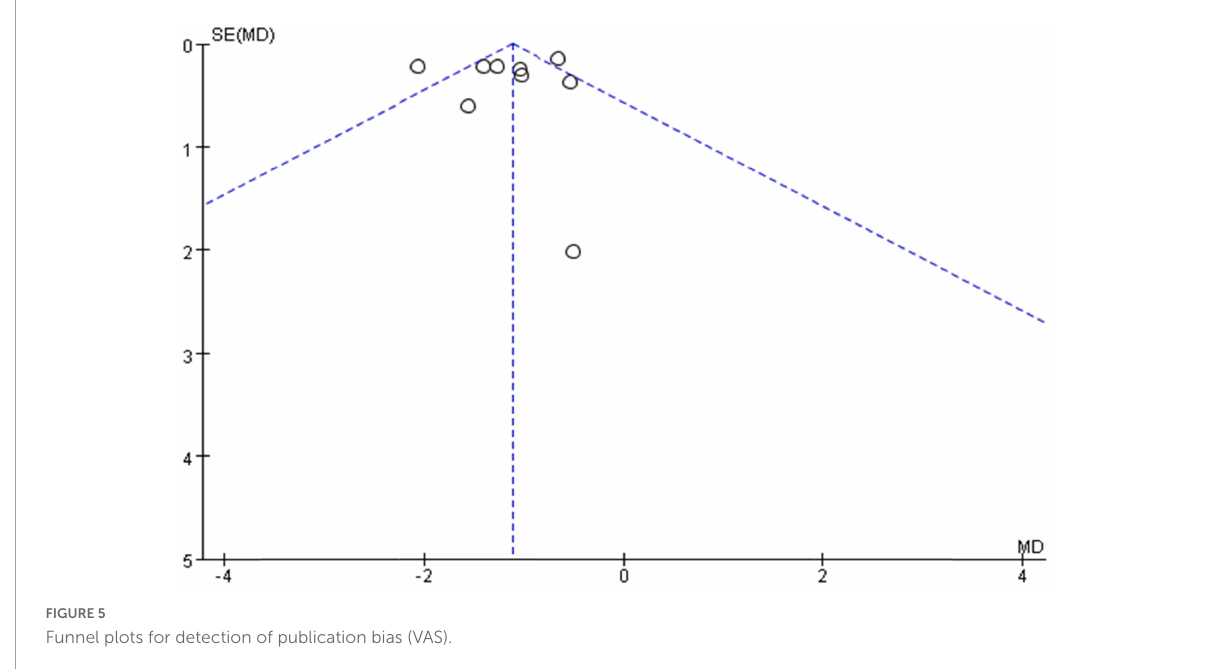
FIGURE5 Funnel plots for detection of publication bias (VAS).